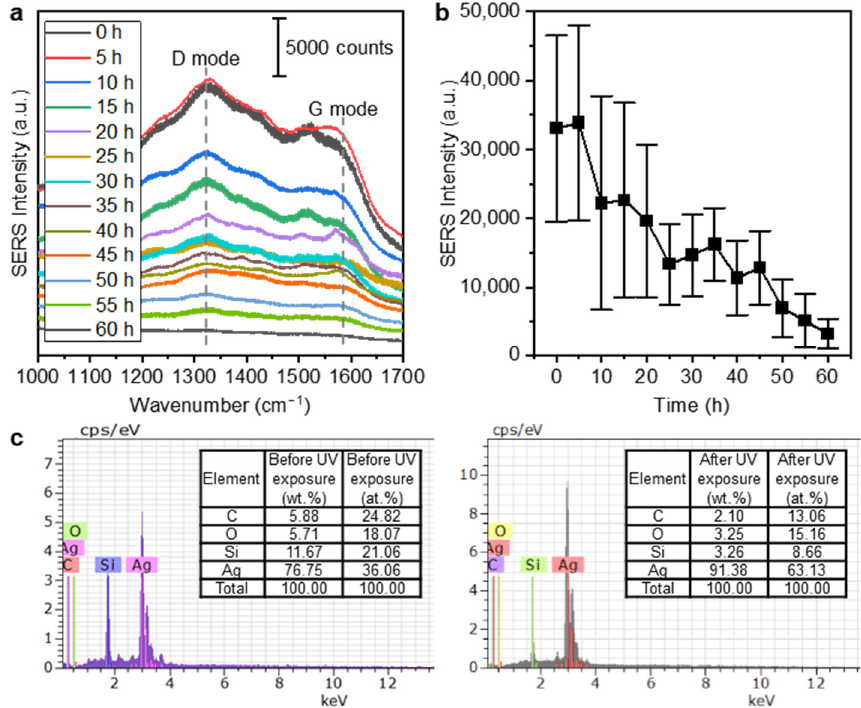
Figure 3. ( a ) SERS intensity spectra of substrates showing gradual carbon decomposition by UV irradiation within the time period from 0 to 60 h; ( b ) reduction in carbon intensity during UV irradiation; and ( c ) EDS data before and after the substrates were subjected to UV irradiation.